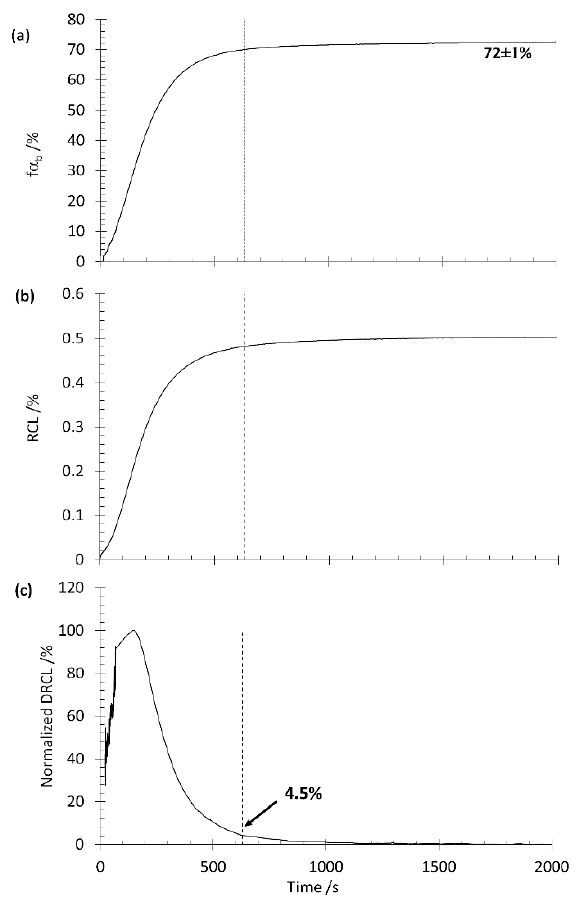
Figure 7. For Steel 3, results from simultaneous in situ high energy X-ray diffraction (HEXRD) and dilatometry during isothermal bainitic transformation at 400 °C. ( a ) Experimental fraction of bainitic ferrite ( f α ) a s a function of time, ( b ) the relative change in length (RCL) from the dilatometry test, and ( c ) normalized derivative of the relative change in length (DRCL). The vertical dotted line denotes the limits of Region 3 as described in the main body of the text.